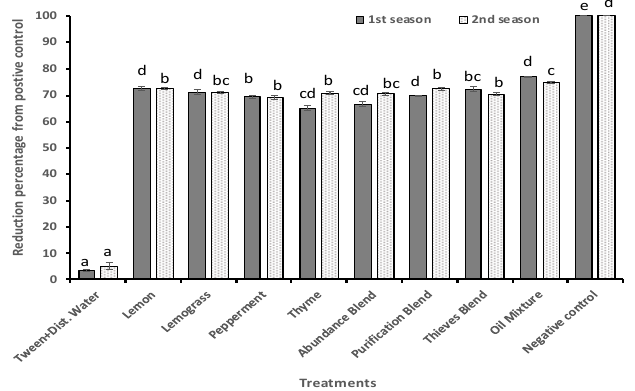
Figure 2. Effect of treatment with essential oils on the disease severity (reduction % from the positive control) of powdery mildew on the cucumber plant. The vertical bar represents the standard error ( n = 3). Columns in the same color and followed by different letter(s) are significantly different at p < 0.05.